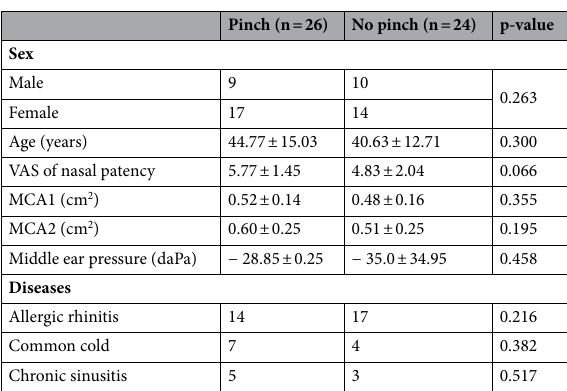
Table 1. Baseline characteristics.